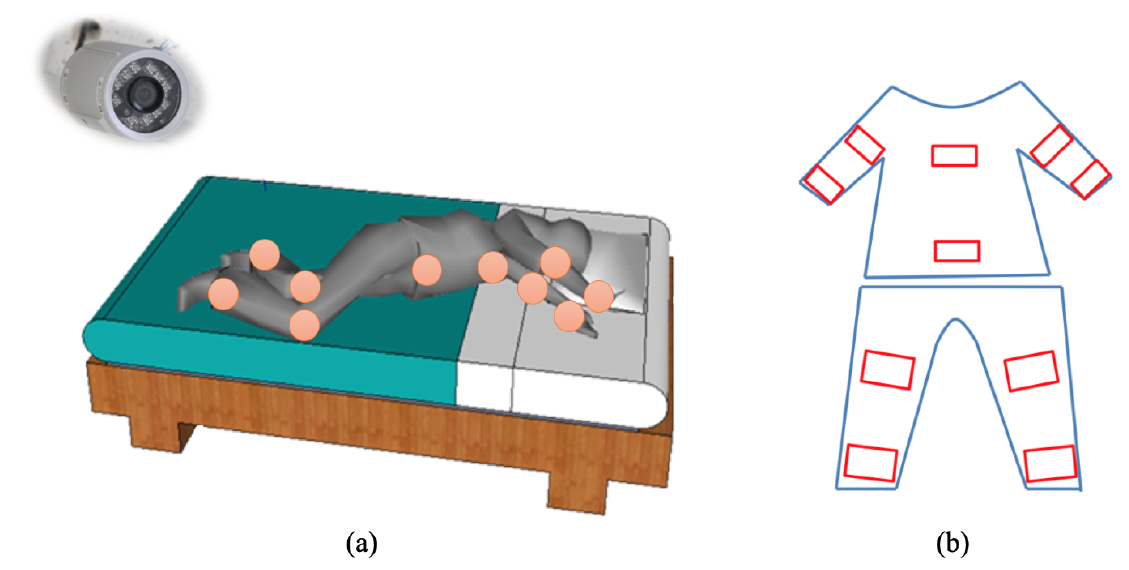
Figure 1. The proposed scheme for sleep pose recognition. ( a ) An infrared camera is used to acquire the sleep videos and analyze body joint positions. ( b ) Pajamas with ten near infrared (NIR)-sensitive patches are designed to facilitate the detection of body